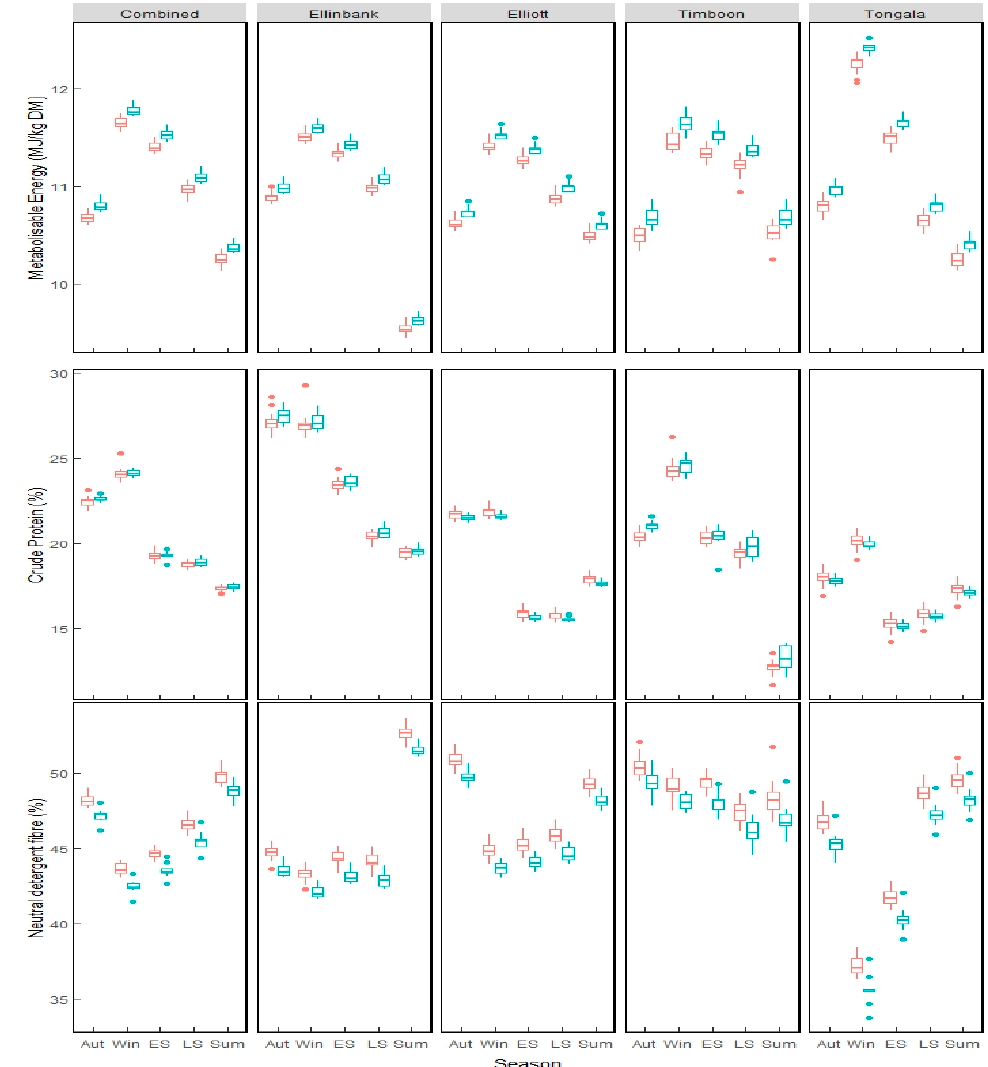
Figure 1. Seasonal variation in the nutritive characteristics of diploid ( ) and tetraploid ( ) can- didates common across all trial sites. Results are presented for individual trial sites and for a com- bined sites analysis. The horizontal line on the box plots indicates the median; the box indicates the inter-quartile range (IQR); the vertical whiskers indicate values within 1.5 times the IQR above the 75th percentile and below the 25th percentile. Outliers represented by dots are greater than 1.5 times the IQR beyond either end of the box.